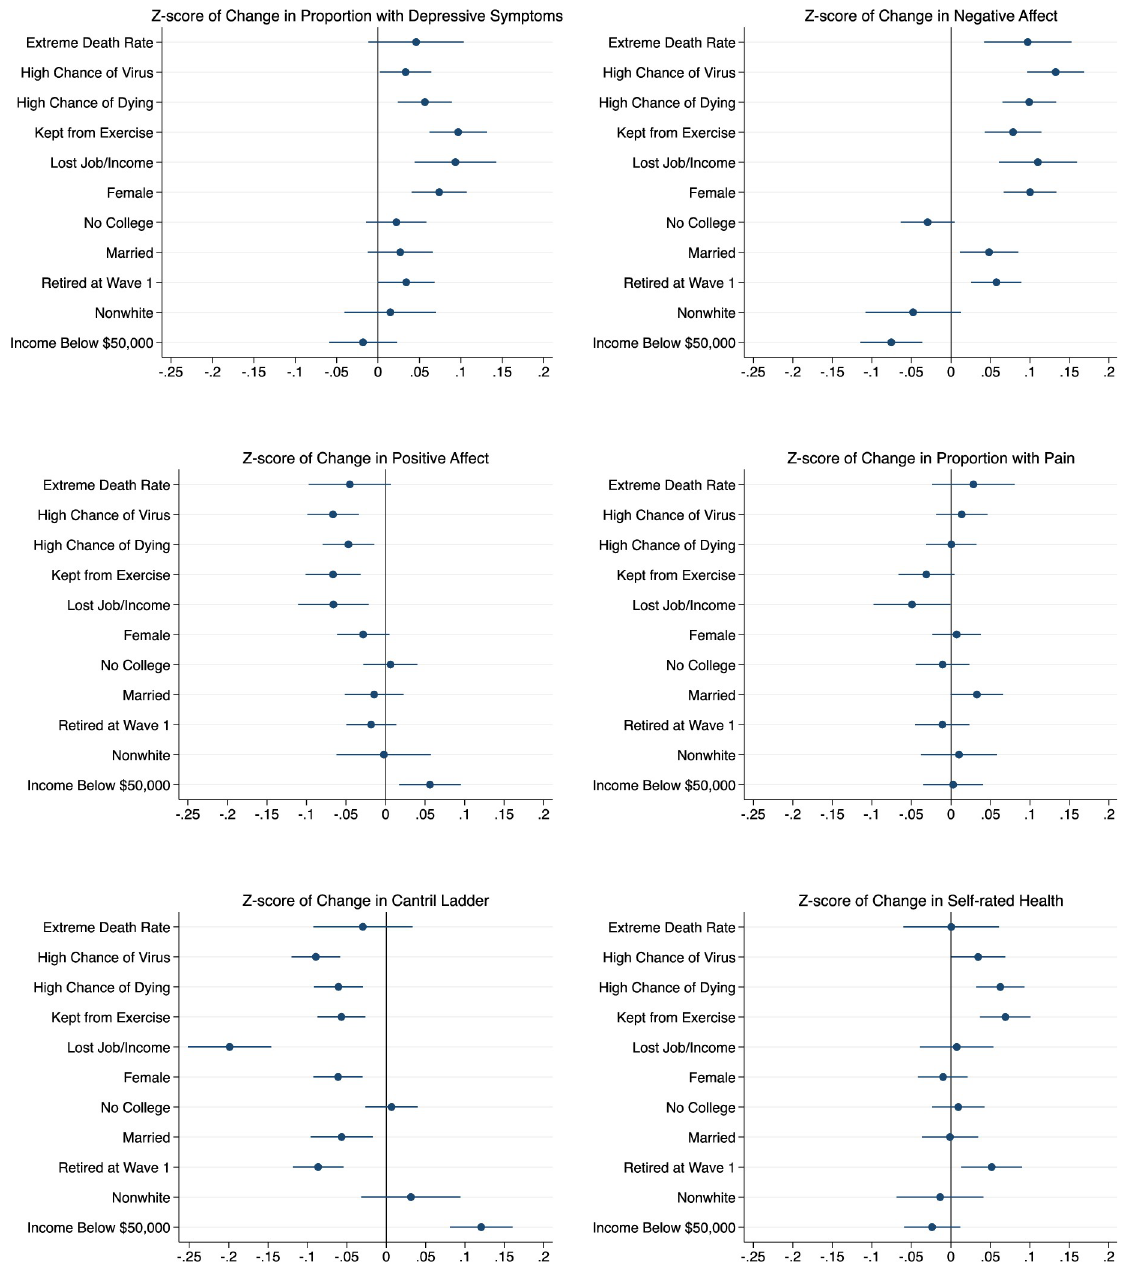
Fig 2. Impact of demographics and COVID-19 factors on changes in well-being. Notes: Estimates are from the z-score of first-difference regression models specified in Eq (2).“Extreme Death Rate” means the respondent lived in a county that was in the 90 th percentile of COVID-19 death rates the day before the respondent answered the wave 2 survey. “High Chance of Virus” means the respondent rated their odds of contracting the virus above the median respondent. “High Chance of Dying” means that once infected, the respondent rated their odds of dying from the virus above the median